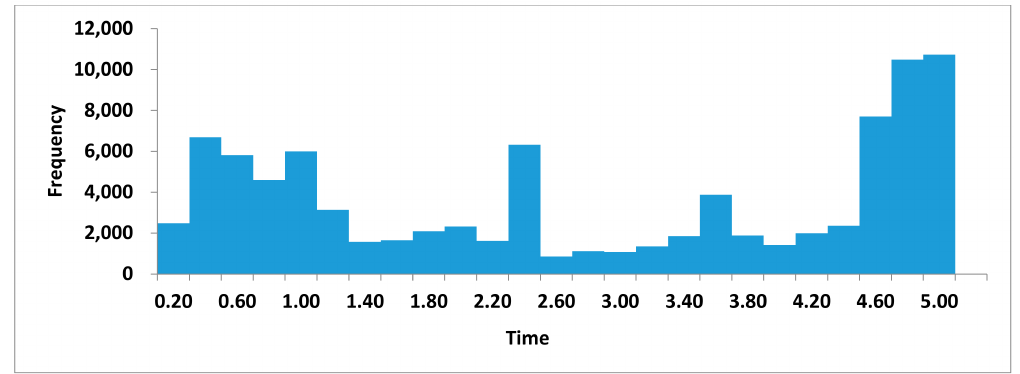
Figure 11. Exercise of the option to abandon up to T = 5 years.